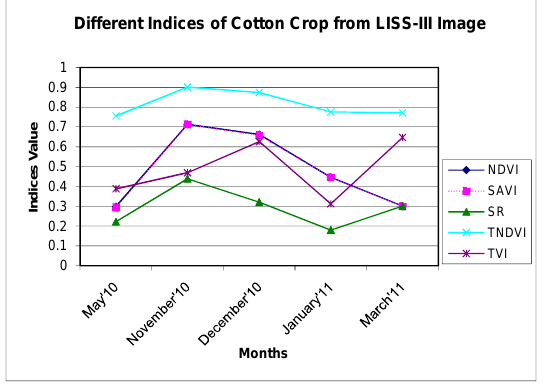
Figure 3: Different indices of cotton crop from LISS-III image